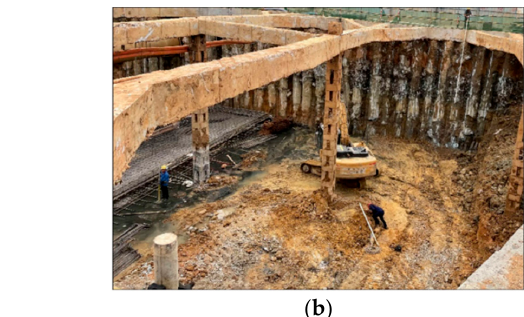
Figure 17. The posterior probability distributions of the time slices of T3, T11 and T14, as ( a ), ( b ) and ( c ), respectively.